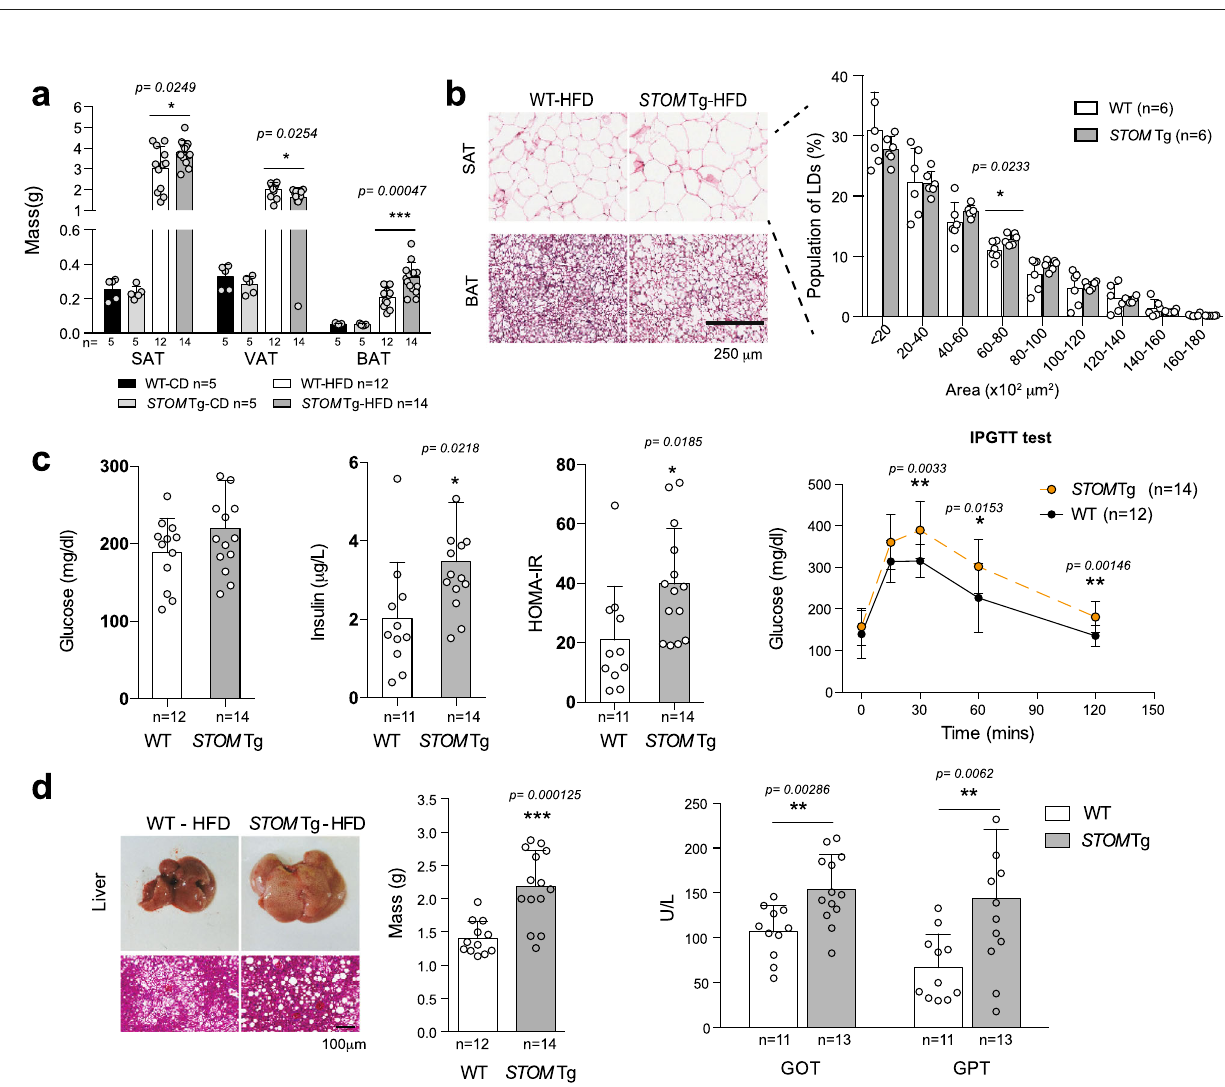
Fig. 4 Stomatin transgenic mice fed with high-fat diet were more obese than the control mice. a Real-time qPCR analyses validated increased stomatin gene expressions in SAT, VAT, including Perigonadal fat pad (PG) and Perirenal fat pad (PR), and BAT after regular CD or HFD feeding. Mean ± s.d. for six mice. ** P < 0.01 and *** P < 0.001, by multiple unpaired t test. b Western blotting revealed high expressions of human stomatin (hSTOM) proteins in stomatin transgenic mice ( STOM Tg). c The exogenous hSTOM proteins were present mainly on the plasma membranes of adipocytes in fat tissues of STOM Tg mice. d Body weight changes of STOM Tg and wild type (WT) mice during CD or HFD feeding for 20 weeks. Mean± s.d. of mice, * P < 0.05 analyzed by multiple unpaired t tests. Representative photos of the mice are shown. e Body weight increments after 20-week feeding were measured. Each dot represents one mouse. While no difference was noticed in animals fed with CD, body weight gains were signi fi cantly higher in HFD-fed STOM Tg, compared to HFD-fed WT mice. Mean± s.d. is shown. n.s = non-signi fi cant. ** P < 0.01 by two-sided unpaired t -test. f The mass of whole body, fat, lean, free fl uid, and total water were calculated by body composition analyzer for HFD-fed STOM Tg and HFD-fed WT mice. P values were examined by multiple unpaired t test. g Fatty acid uptake was measured in vivo. Fluorescently-labeled fatty acid Bodipy-FL-C 16 , or BSA, were injected into tail vein of STOM Tg or WT mice. After 15 min, lipid portions of white adipose tissue (WAT) from the animal were extracted and their fl uorescence signals that represented lipid uptake were quanti fi ed. Data shown are fold changes of fl uorescence intensity using BSA injected to WT mice as the reference. Each dot represents one mouse. Mean ± s.d. for mice from two independent experiments. * P < 0.05, *** P < 0.001, and **** P < 0.0001 by two-way ANOVA. Source data are provided as a Source data fi le.